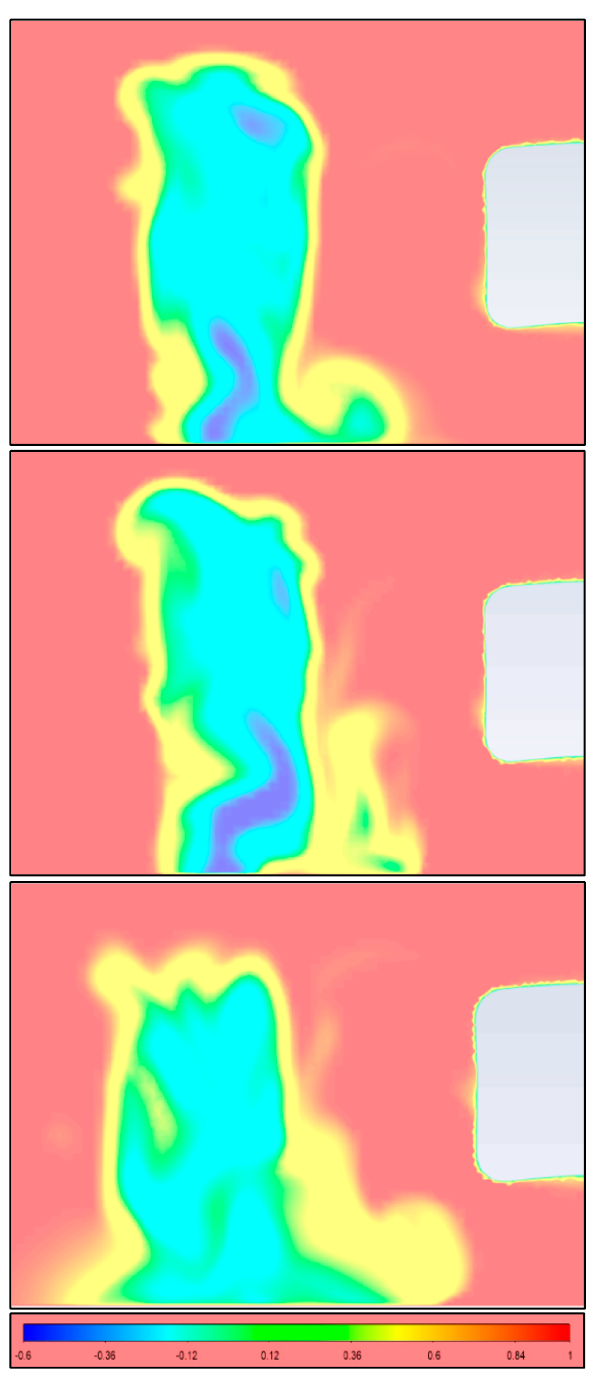
Figure 11. Streamwise velocity at plane z = − 1.75 (behind the wheel) (AOA of 30 ◦ , 32 ◦ , and 34 ◦ ). Further downstream, at plane z = − 2.1 (underbody intake), a similar behavior is observed: the wake structure is again similar between the baseline and the 32 ◦ geometries; however, the strong reversed flow regions are no longer present (see Figure 12). The containment of the wake structure within the profile of the tire may be an explanation for this lack of advection of the reversed flow downstream of the wheel [16].